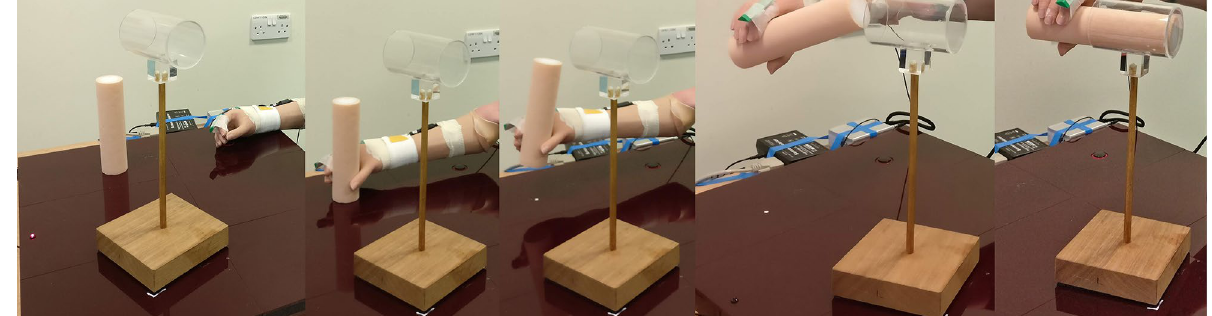
Figure 5. Cylinder task, participants were asked to reach to grasp a nylon cylinder with a foam outer surface (diameter 52 mm, length 200 mm, weight 350 g). Lift it and rotate it to the horizontal before placing it into a transparent tube (inner diameter 64 mm, length 100 mm).